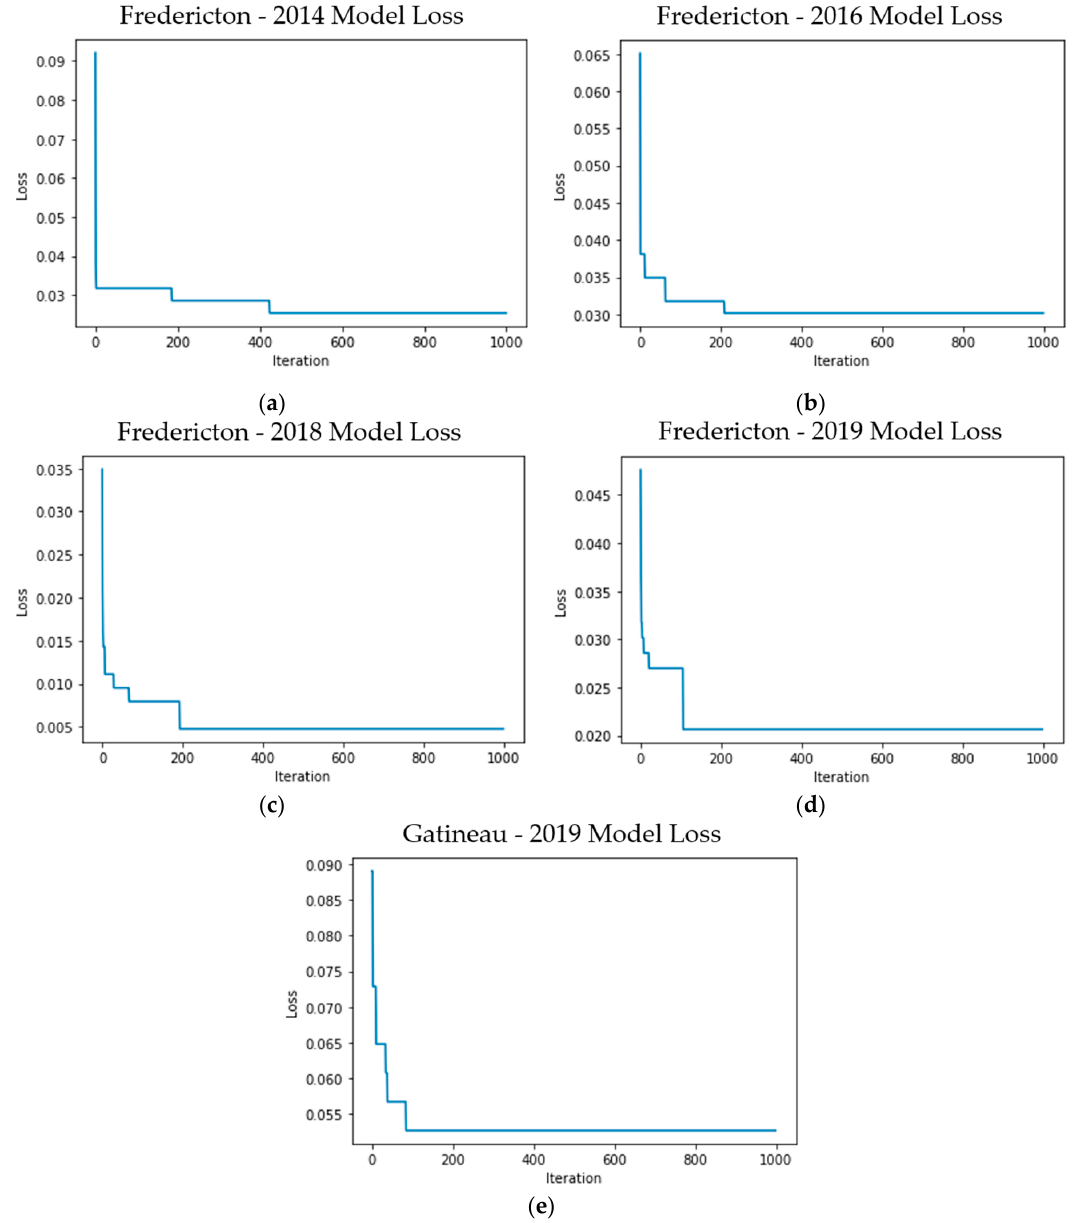
Figure 8. Model loss for Random Forest (R.F.) through a random sample consensus (RANSAC) process representing the demonstrated for five flood datasets of ( a ) Fredericton 2014, ( b ) Fredericton 2016, ( c ) Fredericton 2018, ( d ) Fredericton 2019 and ( e ) Gatineau 2019.